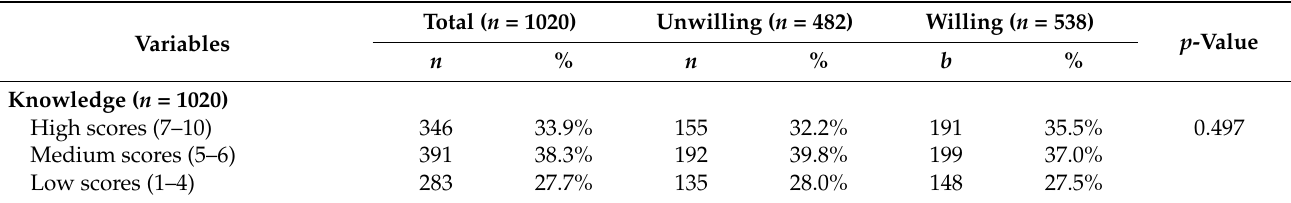
3.2. Comparison of Risk Perception and Factors Influencing Vaccination Willingness between Willing and Unwilling to Receive COVID-19 Vaccine Group Comparisons of risk perception, knowledge, and experience of vaccine refusal be- tween the willing and unwilling to receive a COVID-19 vaccine groups are shown in Table 2. Overall, more than 70% of participants self-rated their perception of their knowl- edge regarding vaccines as medium to high, and 28.6% of them have previously refused vaccinations for themselves. Regarding risk perception, around 63.5% of participants perceived the spread of the COVID-19 pandemic in Taiwan as “not serious”, and nearly 40% responded that they were “not worried” about COVID-19 infection. Participants’ experience with refusing previous vaccines and their perception of the severity of the COVID-19 pandemic in Taiwan were both significantly different between the willing and unwilling to receive a COVID-19 vaccine groups. The percentage of participants with experience of vaccine refusal was significantly higher in the unwilling group (39.3% in the unwilling group vs. 19.1% in the willing group), but the percentage of participants who perceived the COVID-19 pandemic in Taiwan as serious was also significantly higher in the unwilling group (17.1% in the unwilling group vs. 11.6% in the willing group). Knowledge and experience of vaccination and risk perception variables affecting COVID-19 vaccine uptake